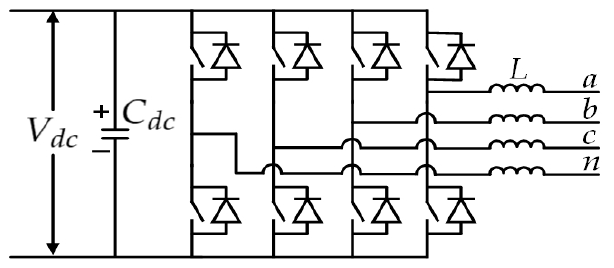
Figure 2. Four-leg inverter topology.